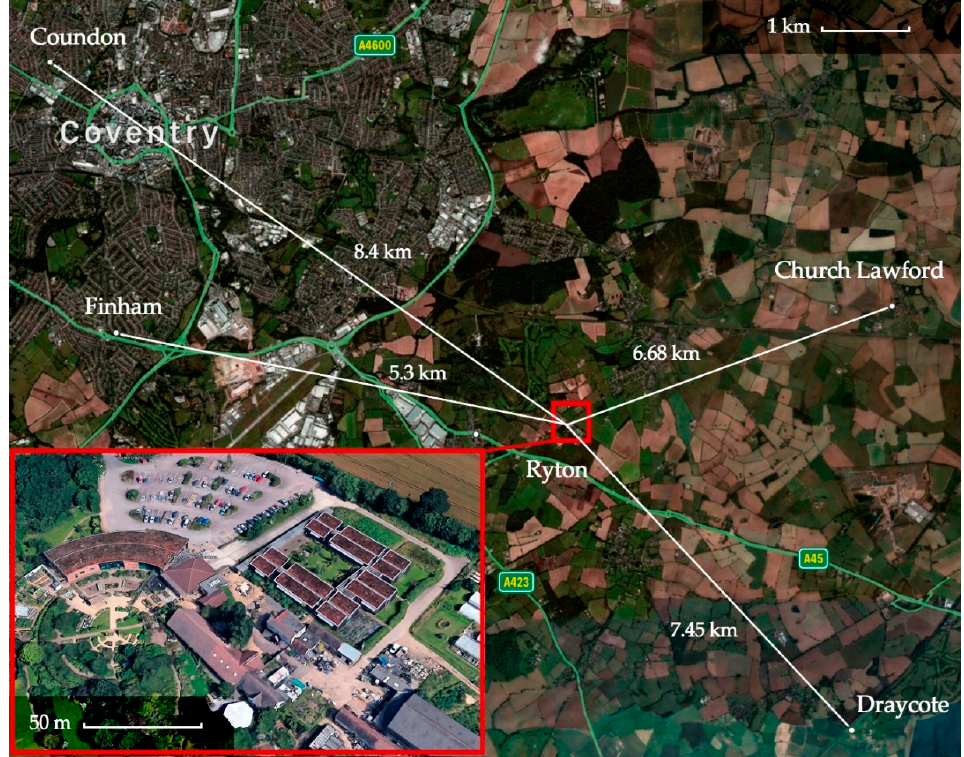
Figure 1. Study area in Ryton-on-Dunsmore, Coventry, and location of the UK Met Office weather Figure stations.